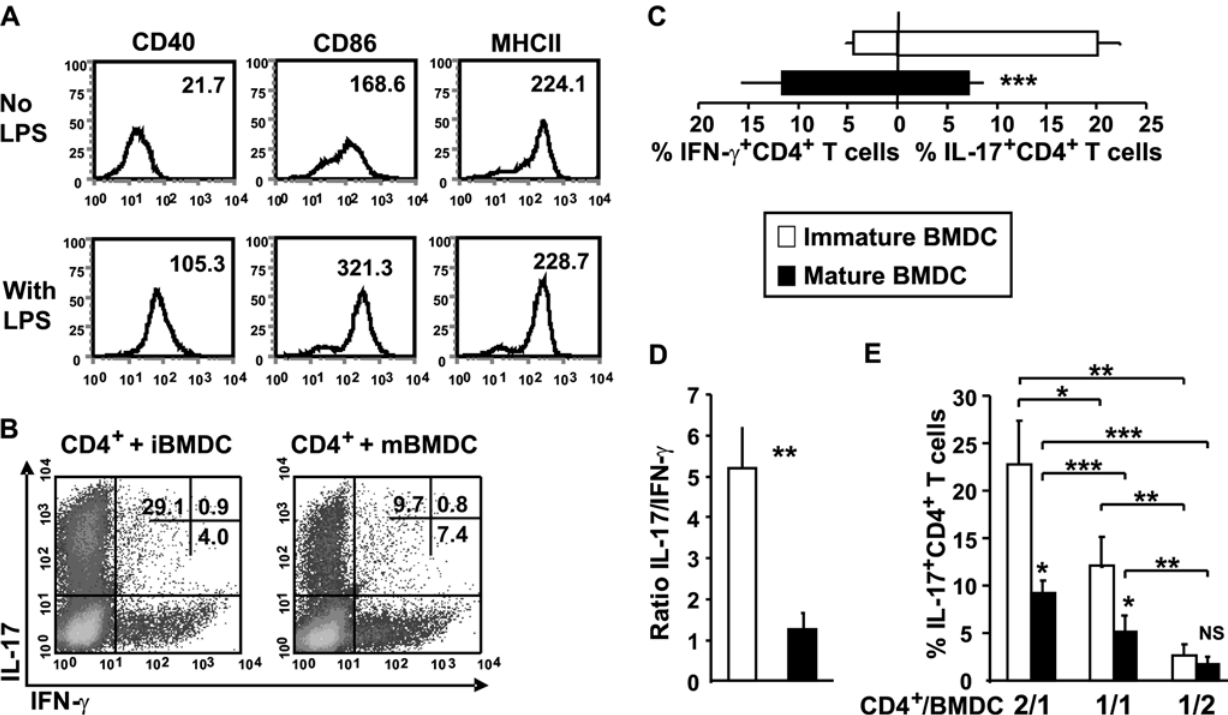
Figure 6. Mature BMDC inefficiently support Th17 differentiation. CD4 + T cells were cultured with immature or mature BMDC at a 2/1 CD4 + / BMDC ratio in the presence of anti-CD3 under Th17 conditions. (A) BMDC were stimulated with LPS (1 m g/ml) and stained for CD40, CD86, or MHCII (IA/IE) expression. The mean fluorescence intensity are shown. Data are representative of one experiment out of three. (B) Cells were stained intracellularly for IL-17 and IFN- c . Shown is one representative experiment out of 6. (C) Cumulative data of the percentage of CD4 + IL-17 and IFN- c positive T cells after restimulation as assessed by intracytoplasmic staining. Data represent the mean 6 SEM of 6 independent experiments. (D) The ratio of the percentage of IL-17 + to IFN- c + cells among CD4 + T cells. (E) CD4 + T cells (2.5 6 10 5 cells) were cultured with immature or mature BMDC at three different CD4 + /BMDC ratios (2/1; 1/1; 1/2) as described in A. Data represent the mean 6 SD of 4 independent experiments. P values were calculated using the two-tailed, paired Student’s t test, *, P , 0.05; **, P , 0.01; ***, P ,